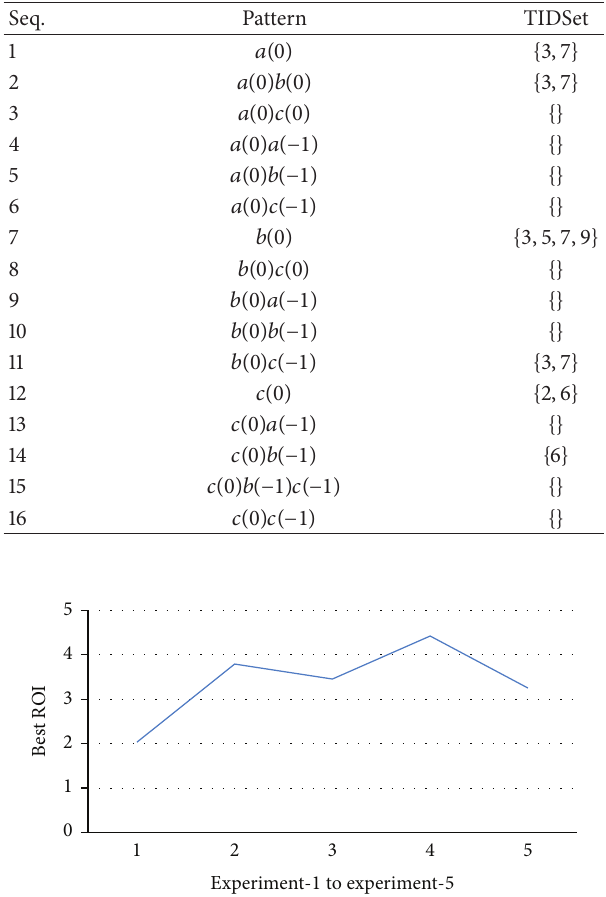
Table 11: The sequence of generated patterns using genSP.